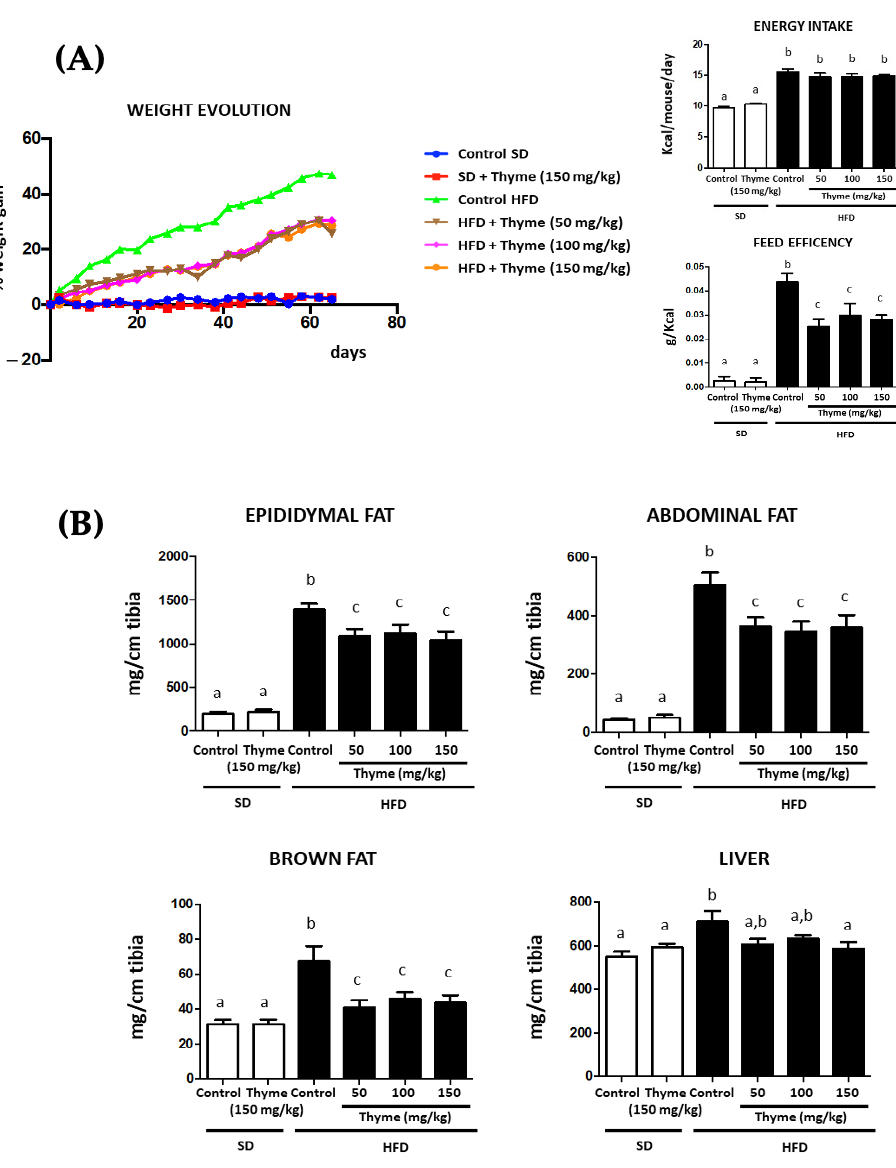
Figure 2. Effects of Thyme extract supplementation on: ( A ) body weight evolution, energy efficiency and energy intake and ( B ) liver and fat deposits weights. Data are expressed as means ± SEM ( n = 10). Groups with different letters statistically differ ( p < 0.05).